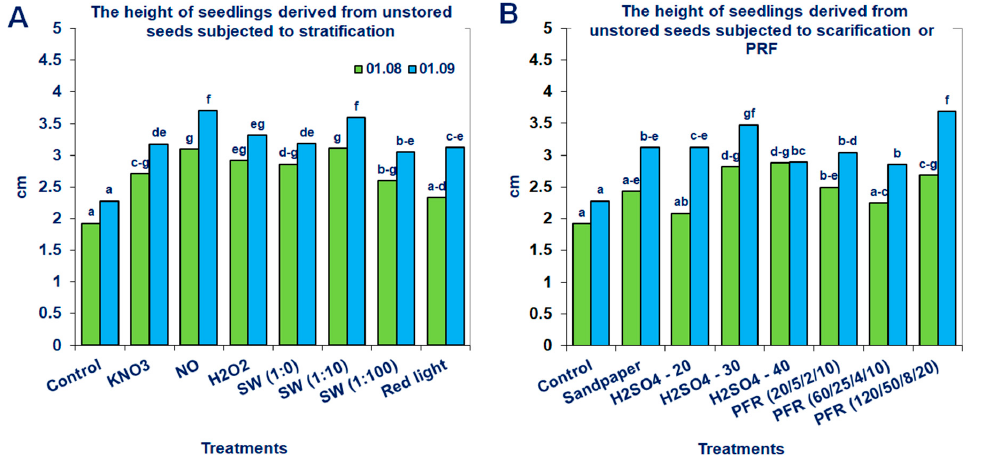
Figure 5. Saskatoon berry seedling heights derived from unstored seeds subjected to ( A ) stratification (3 ◦ C) in the presence of KNO 3 , NO, H 2 O 2 , smoke-water (SW, in concentrations of 1:1, 1:10, 1:100), red light and 20 ◦ C/3 ◦ C or ( B ) scarification: sandpaper, sulfuric acid for 10, 20, 30 and 40 min, or treatments with pulsed radio frequency (PRF, 20/5/2/10, 60/25/4/10, 120/50/8/20). The data within the graph ( A or B ) and the color of the bar and with the same letter do not differ significantly according to Tukey’s test (5%). Values are the means of three replications of 50